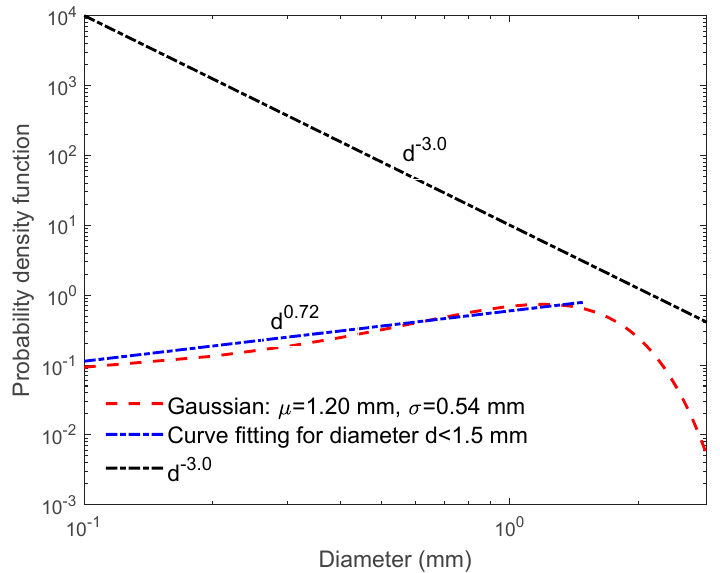
Figure 12. The probability density function of the droplet size distribution and d − 3.0 approximation on a logarithmic scale. The blue dash–dotted line was obtained by curve-fitting the probability density function for a diameter d < 1.5 mm. The product of the two plots gives the d − 2.3 power law reported by Delvigne and Sweeney (1988).